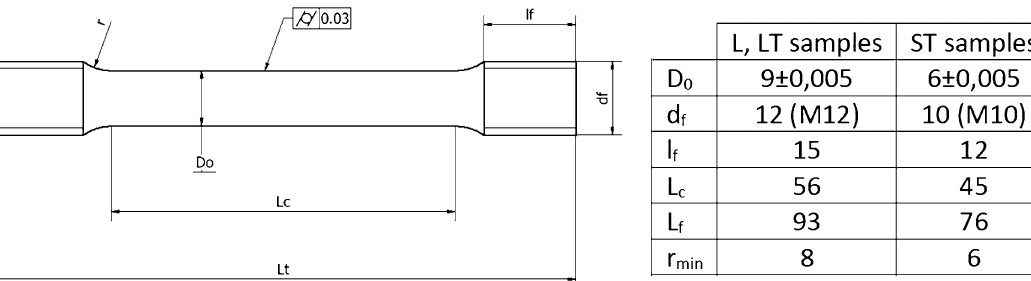
Fig. 2 Drawing and dimensions of the tensile specimens